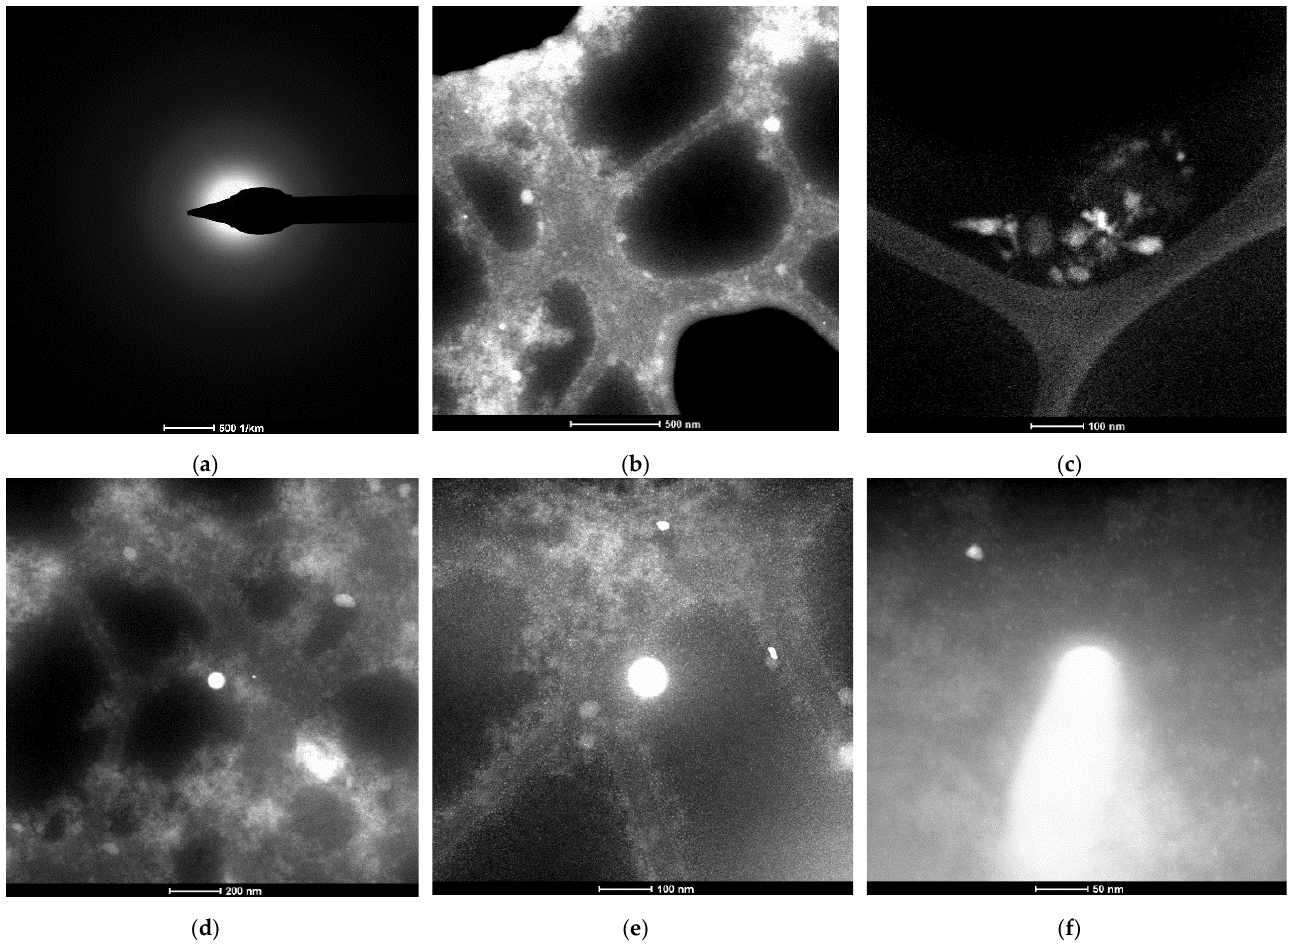
Figure 5. Transmission electron microscopy (TEM) images of membrane nanodispersions after use in the process. ( a ) Selected area diffraction pattern and images at selected magnitudes of: ( b ) 500 nm; and ( c ) 100 nm; ( d ) Highlight the exposure points at 200 nm; and details at: ( e ) 100 nm; and ( f ) 50 nm.